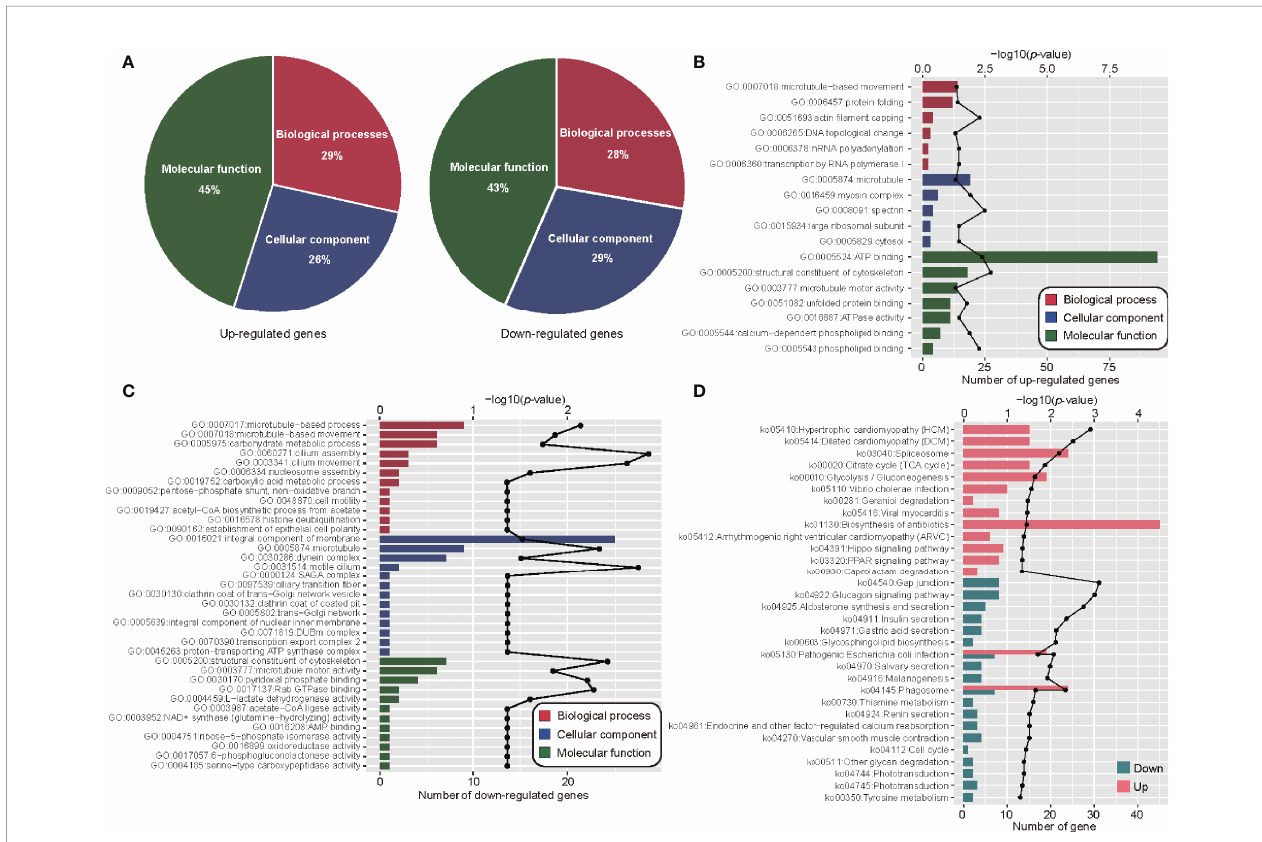
FIGURE 5 | Functional analyses combined transcriptome and proteome. (A) The pie plot shows the classi fi cation of co-up-regulated and co-down-regulated mRNA and proteins in GO function. (B) Co-up-regulated gene enrichment of GO function. (C) Co-down-regulated gene enriched GO function. (D) KEGG enriched function of genes with consistent mRNA and protein expression levels. The discount graph represents the -log10 value of p -value and only shows the results of p -value <